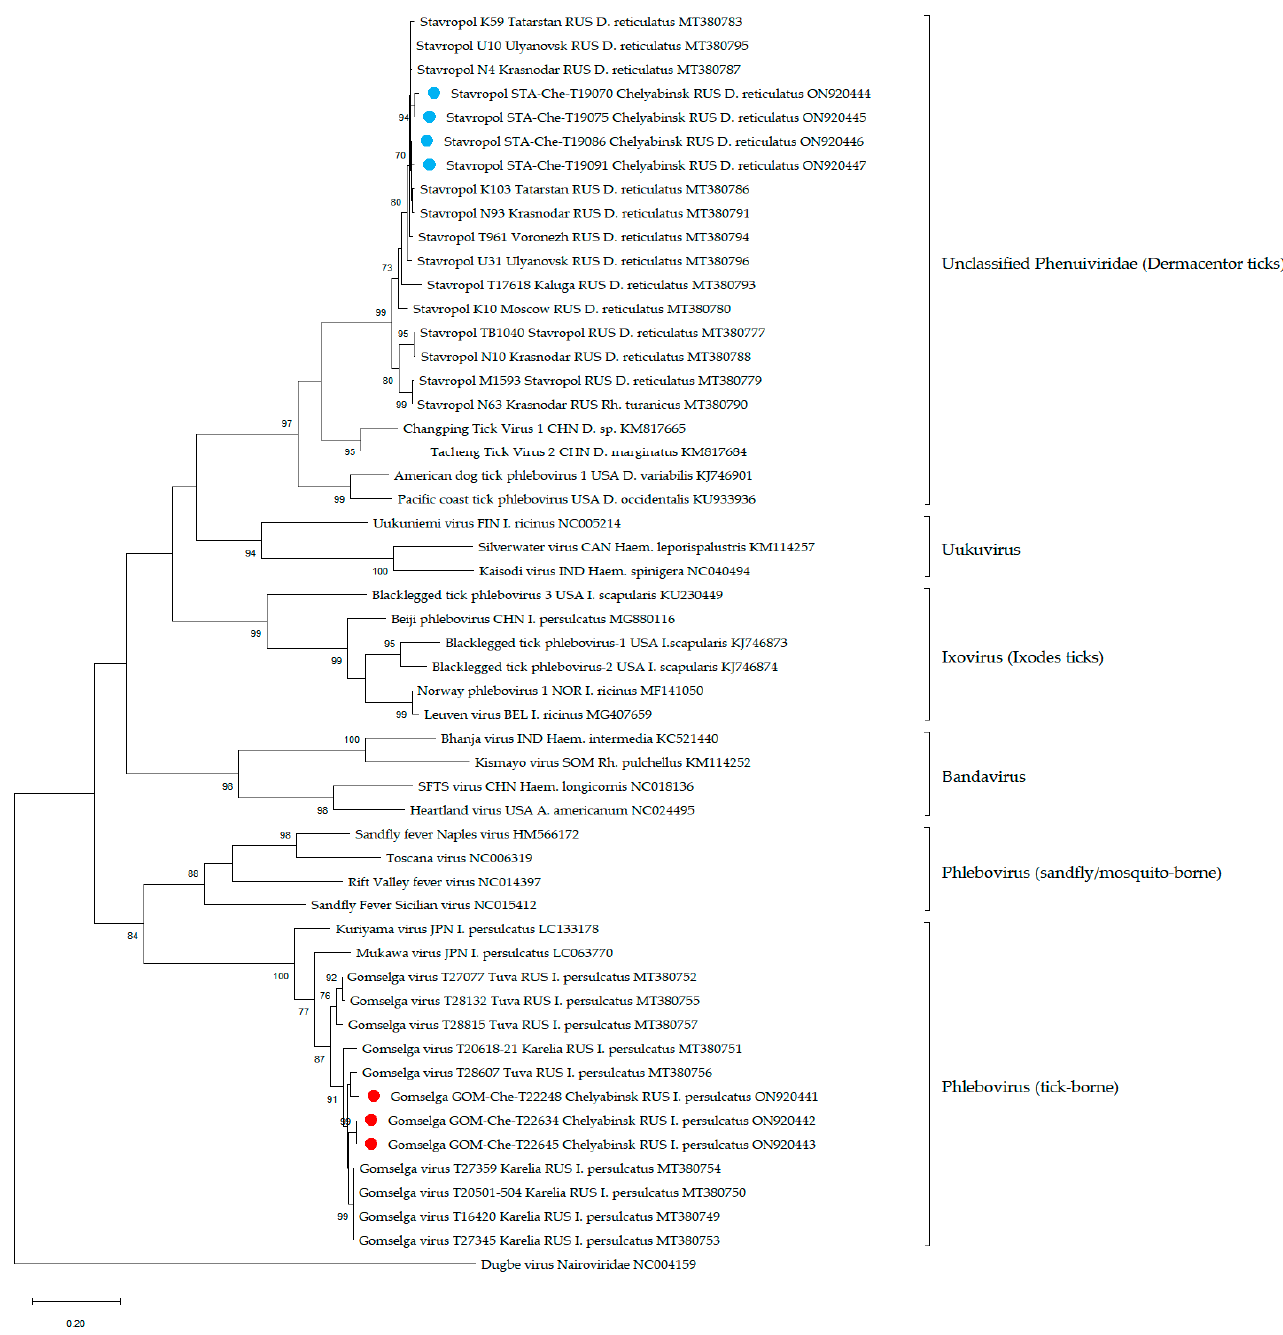
Figure 6. Phylogenetic analysis of the family Phenuiviridae. Phylogenetic trees were constructed using fragments of the L segment (474 bp) in MEGA X with the maximum likelihood method (1000 bootstrap replications). Bootstrap values (>70%) are shown at the branches. Blue circles—amplicons of the unclassified phenuivirus from the Chelyabinsk region described in this study. Red circles—amplicons of the phlebovirus from the Chelyabinsk region described in this study.